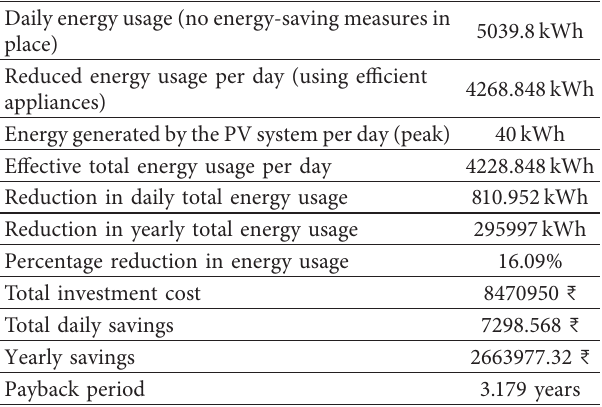
Table 14: Final cost savings and payback